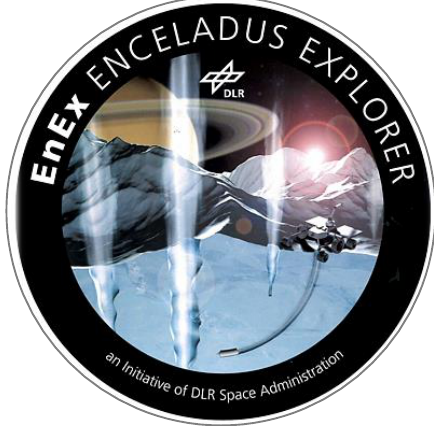
Figure 8: EnEx initiative logo. (Credit: DLR Space